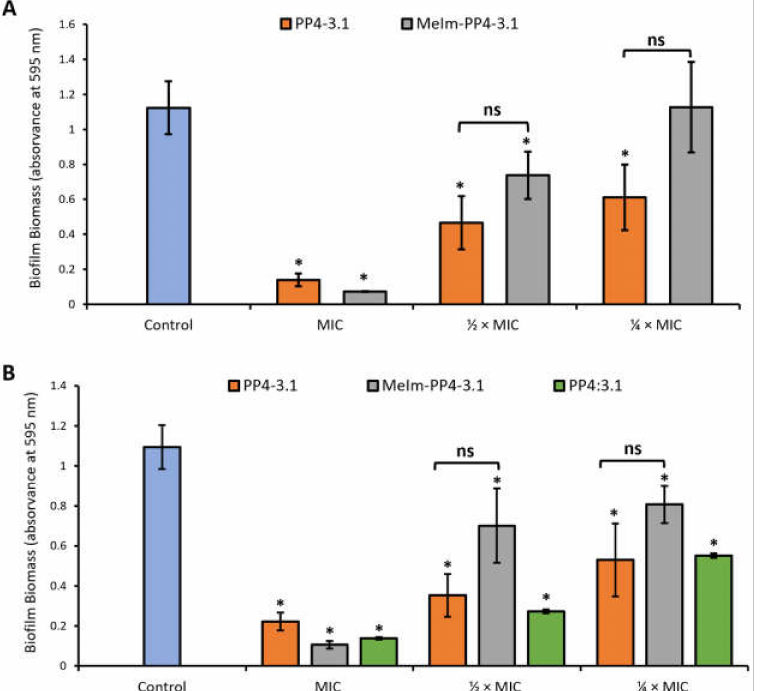
Figure 1. Biofilm biomass formed by MDR clinical isolates of ( A ) S. aureus (SA007) and ( B ) K. pneumoniae (KP010), in the presence of PP4-3.1, MeIm-PP4-3.1 and the noncovalent equimolar mixture PP4:3.1. The test peptides were added to culture medium (TSB) at MIC, 1 / 2 × MIC and 1 / 4 × MIC (with reference to MIC values obtained in TSB, see text). Control biofilms were grown in the absence of peptide. Data are representative of two independent experiments performed in triplicate. The error bars represent the standard deviation (SD). ns: not significant; Statistically significant differences between biofilms formed in the presence of the peptides and respective control biofilms without peptide ( p < 0.05) are marked with an asterisk ( ∗ ).